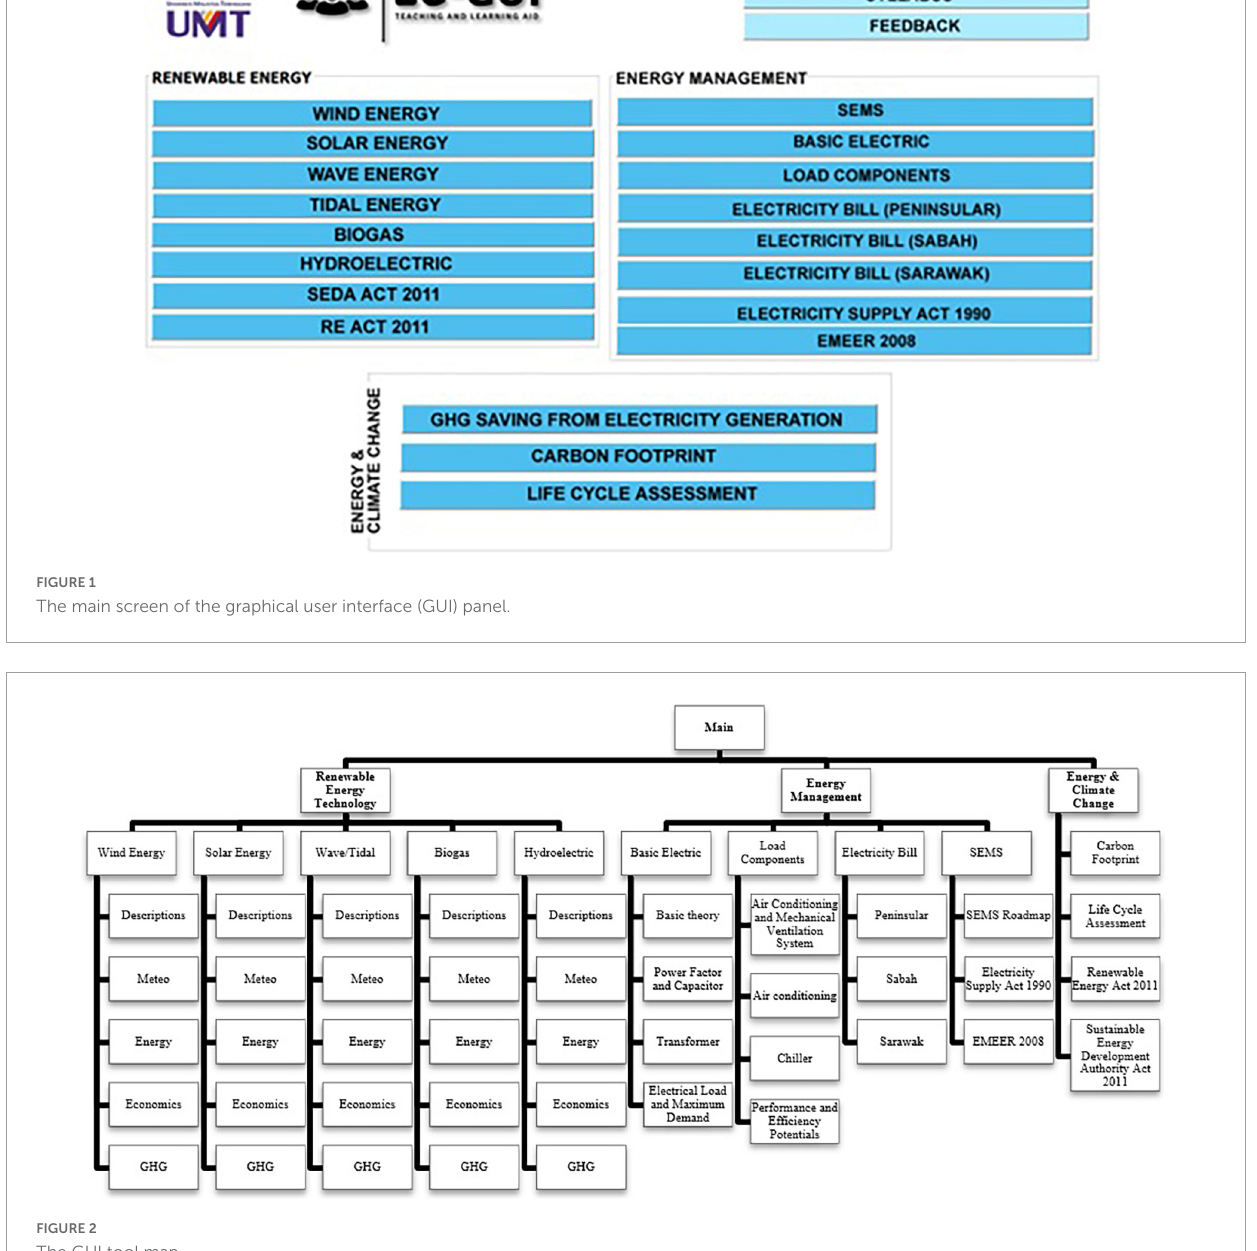
FIGURE2 The GUI tool